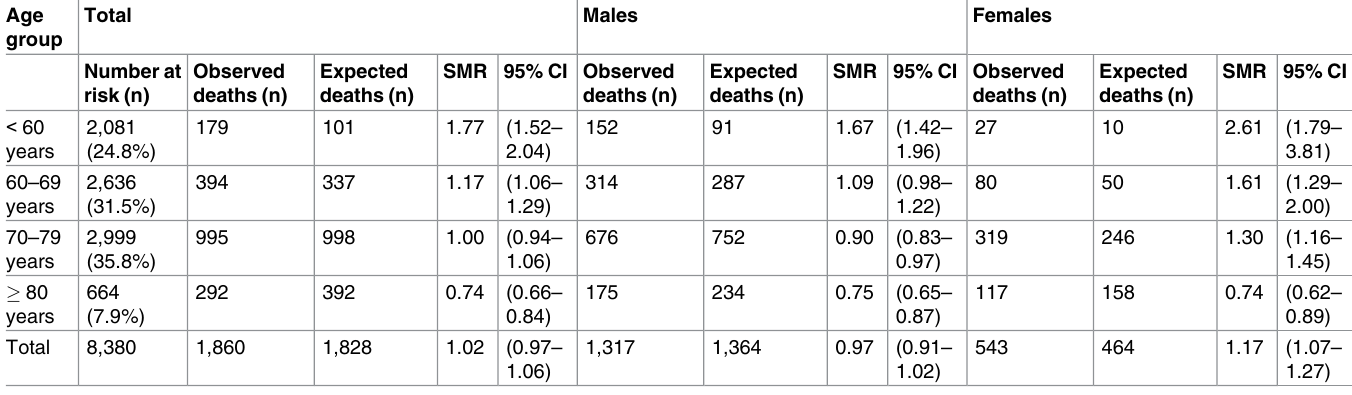
Table 1. Standardized mortality ratios stratified on gender and age group (n = 8,380). Age Total Males group